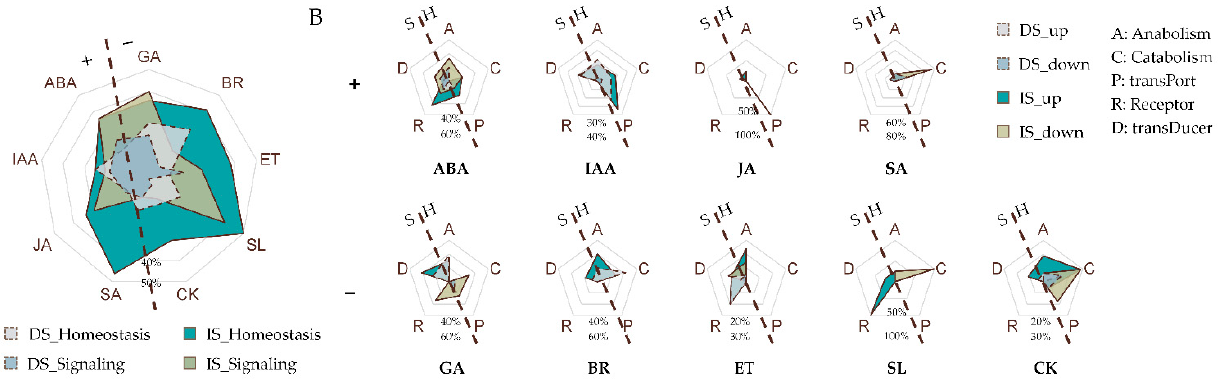
Figure 4. The homeostasis or signaling DEGs of different phytohormones were variously affected in dog1–2 . ( A ) The proportion of the homeostasis and signaling DEGs of phytohormones. The dashed line divides the phytohormones into two classes: “+” denotes the phytohormones that induce seed dormancy or inhibit seed germination; “ − ” denotes the phytohormones that release seed dormancy or promote seed germination. DS, dry seeds; IS, imbibed seeds. ( B ) The proportion of up- or down- regulated DEGs involved in the anabolism, catabolism, and transport, as well as the signal reception and transduction of the indicated phytohormone. The dashed line divides the five categories into two classes: S, Signaling; H, Homeostasis.